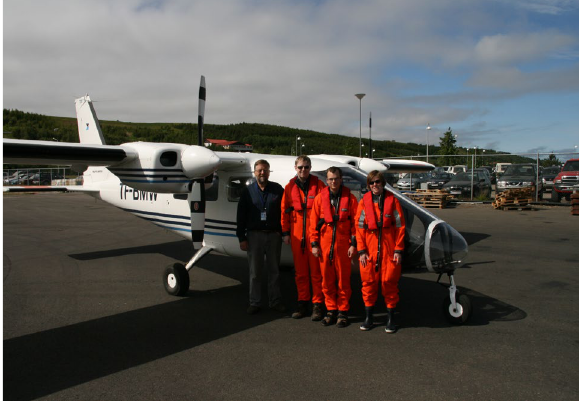
Figure 3. Survey crew and pilot of the 2007 survey in Iceland. The same aircraft, a Partenavia P-68 Observer with 1 set of bubble windows, was also used in the Faroese survey in 2010. (Photo by Daniel